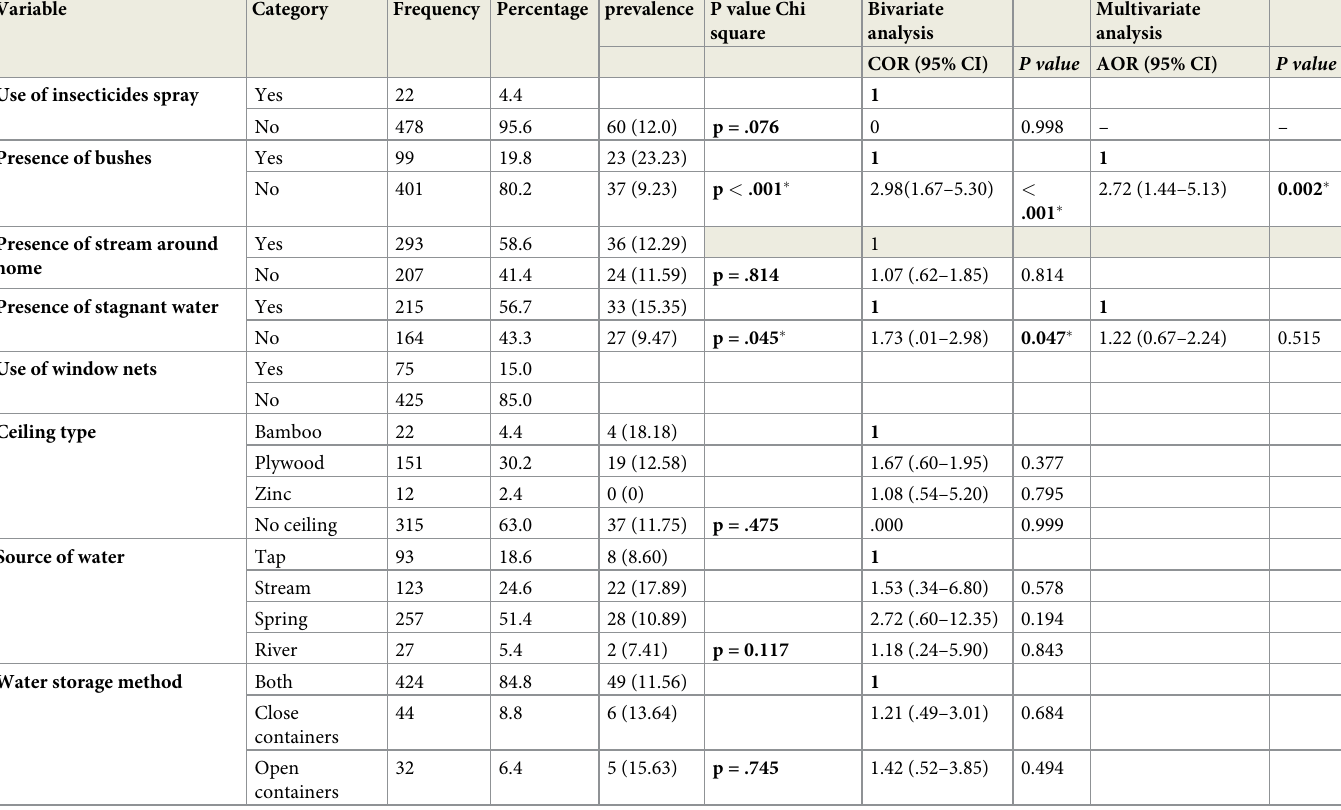
Table 3. Environmental and behavioral characteristics of the study population in relation to malaria